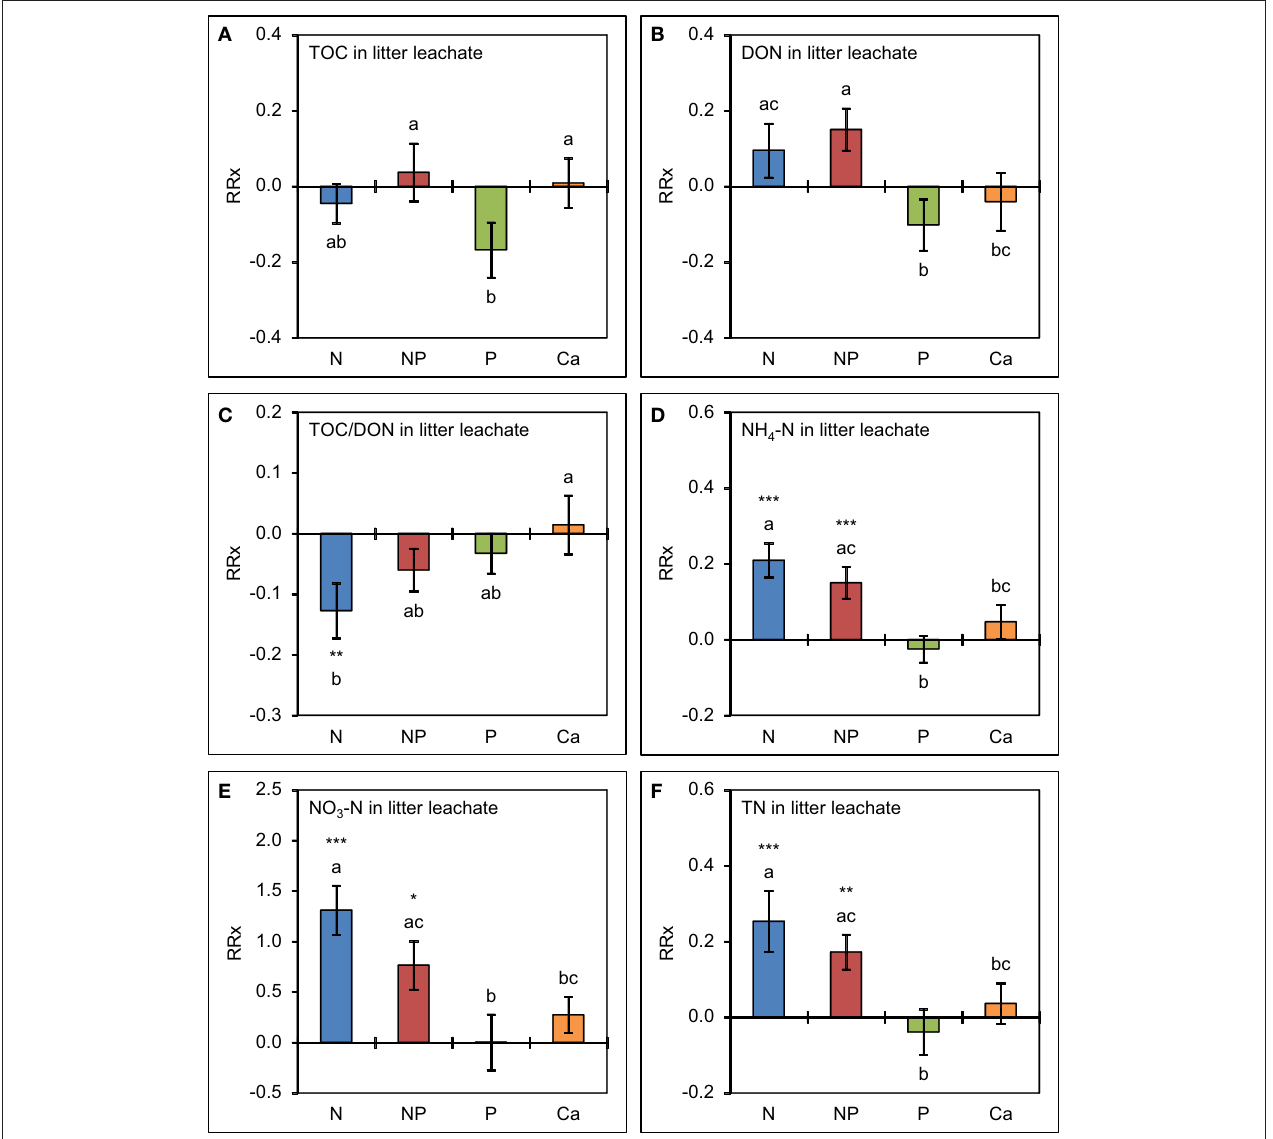
FIGURE 5 | Cumulative effects of nutrient manipulations observed in litter leachate after 5 years of nutrient additions. The diagrams show the average responses over 5 years of (A) total organic carbon (TOC) concentrations, (B) dissolved organic nitrogen (DON) concentrations, (C) TOC/DON ratios, (D) ammonium-N (NH 4 -N) concentrations, (E) nitrate-N (NO 3 -N) concentrations, and (F) total nitrogen (TN) concentrations to nutrient additions expressed as natural log-response ratios (RRx) between the respective treatments ( n = 4 ) and the unfertilized control plots ( n = 4 ). Error bars indicate plus or minus one standard error. Asterisks indicate significant differences to the control ( * p < 0.05 , ** p < 0.01 , *** p < 0.001 ). Values not sharing a common letter are significantly different from each other ( p < 0.05